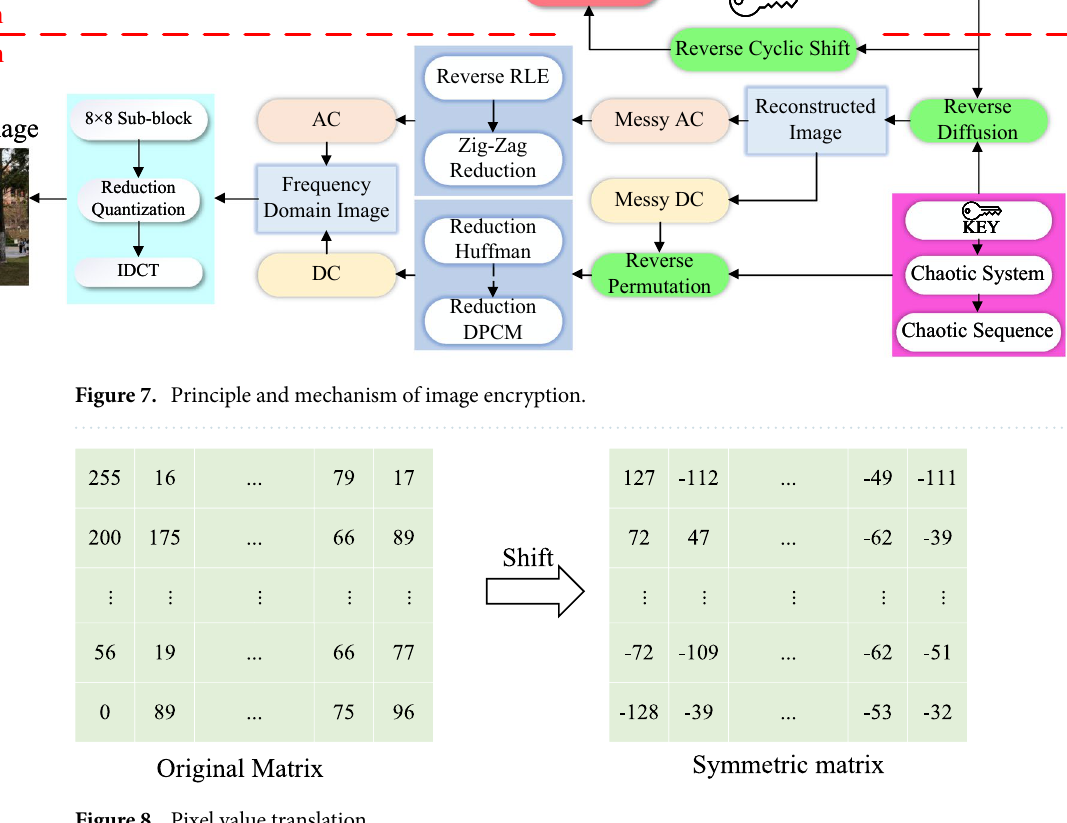
Figure 8. Pixel value